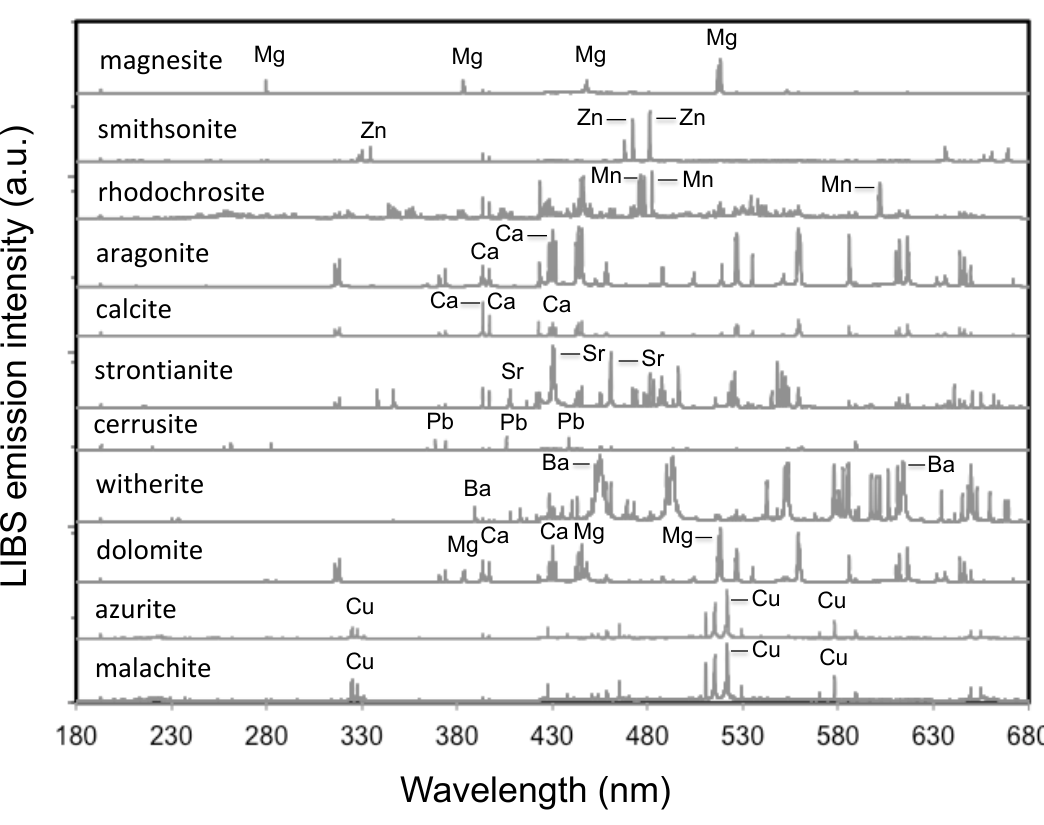
Figure 3. Single-pulse LIBS spectra acquired with a SciAps Z-500 handheld analyzer for a suite of divalent metal carbonate minerals (data from Reference [79]). From top